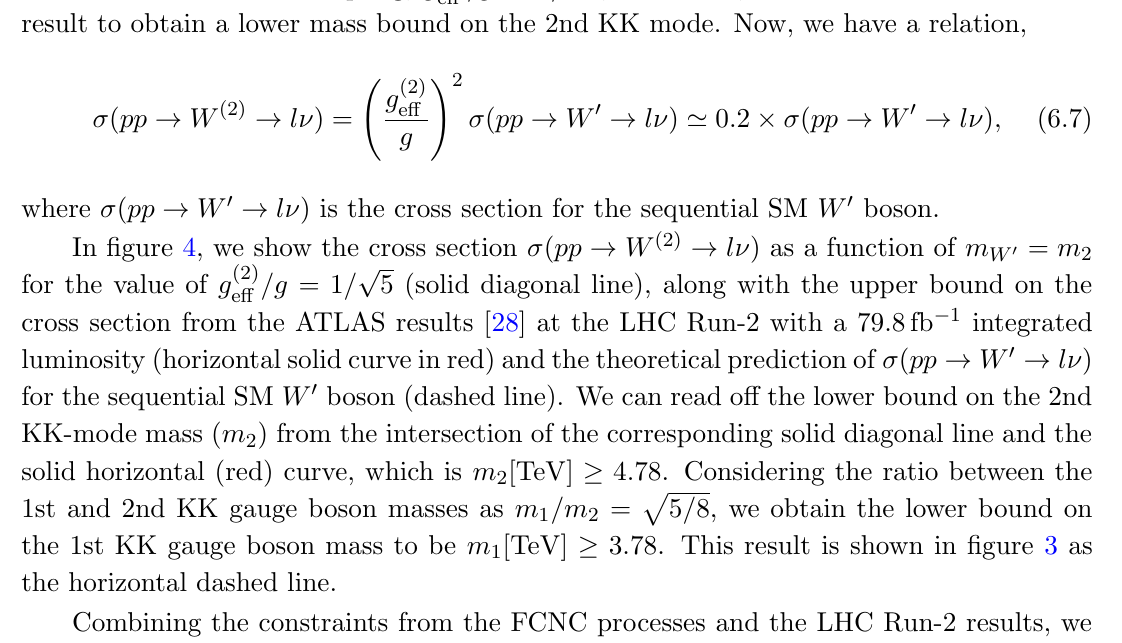
Figure 4 . The cross section times its branching ratio, (cid:27) ( pp ! W (2) ! l(cid:23) ) = (cid:27) ( pp ! W ( 2))BR( W (2) ! l(cid:23) )), as a function of m W 0 = m 2 for g (2) along with the theoretical prediction of (cid:27) ( pp ! W 0 ! l(cid:23) ) for the sequential SM W 0 boson (dashed diagonal line) and the cross section upper bound at 95% Con(cid:12)dence Level (solid horizontal curve in red) from the analysis by the ATLAS collaboration with the integrated luminosity of 79.8 fb (cid:0) 1 [28]. Here, the 1 (cid:27) (green) and 2 (cid:27) (yellow) expected limit bands are also